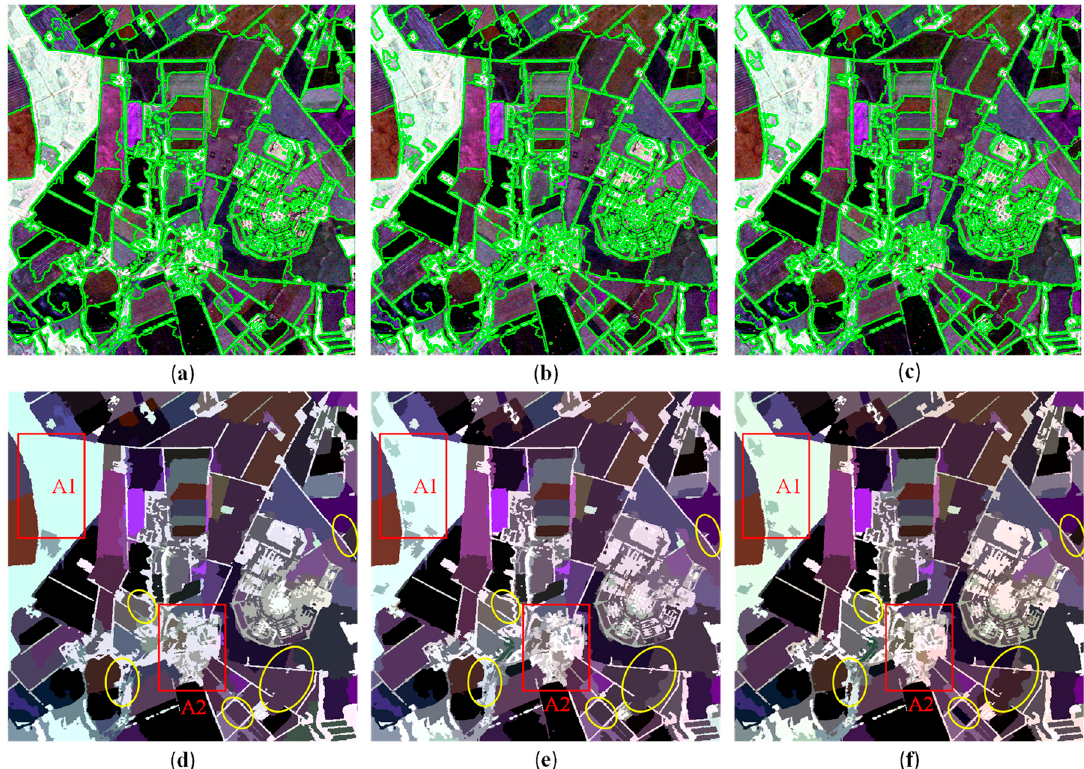
Figure 11. Comparison of the segmentation results of EMISAR data. The first, second, and third columns correspond to the results of IM-Wishart, IM-KummerU, and the proposed method, respectively. ( a – c ) show the final segmentation results, and the green lines depict the boundaries of the segmented regions; ( d – f ) are the corresponding representation maps. Table 1. Numerical evaluation measures of the segmentation results using different methods.